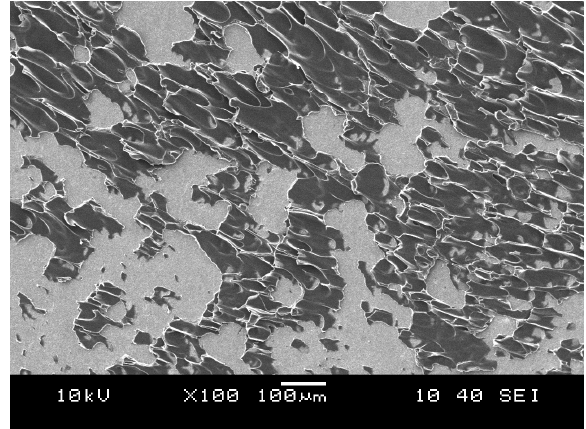
Figure 4. Cohesive failure of the PMMA near the steel-polymer interface (SEM image of the steel sur- face)